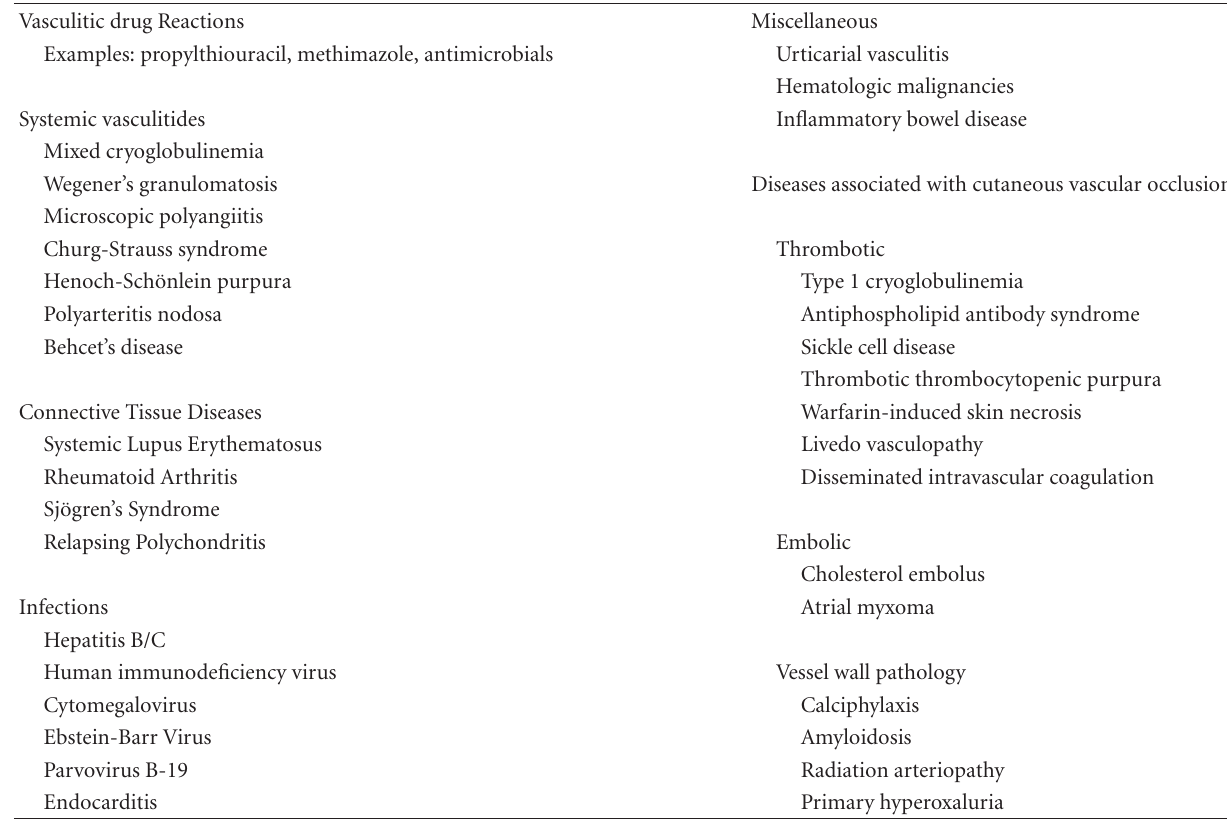
Figure 1: (a) Leukocytoclastic vasculitis of thin walled, papillary dermal vessels characterized by mural fibrinoid necrosis and nuclear dust (arrow). A marked perivascular neutrophilic infiltrate and many extravasated red blood cells are present (hematoxylin and eosin stain; 100 × ). (b) Intraluminal monoclonal immunoglobulin casts in superficial papillary dermal vessels. Note swollen endothelial cells (arrow) (periodic acid-schi ff stain, 400 × ). Table 1: Diseases associated with cutaneous leukocytoclastic